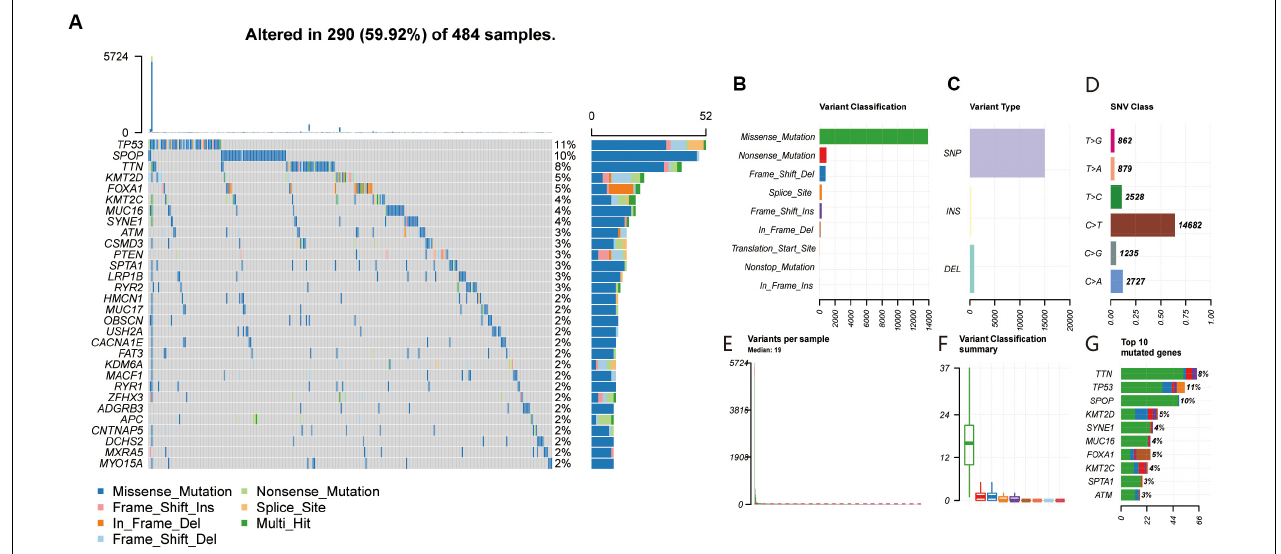
FIGURE 1 | (A,F) Landscape of mutation profiles in PRAD samples. Mutation information of each gene in each sample was shown in the waterfall plot, in which various colors with annotations at the bottom represented the different mutation types. The figure showed the genes with the top 30 of tumor mutation burden. (B,C) The three variant types, and SNP showed more frequency than insertion or deletion. (D) The six variant types of single nucleotide variants, and C > T was the most common of SNV. (E) The number of altered bases in each sample. (G) The top 10 mutated genes in PRAD.